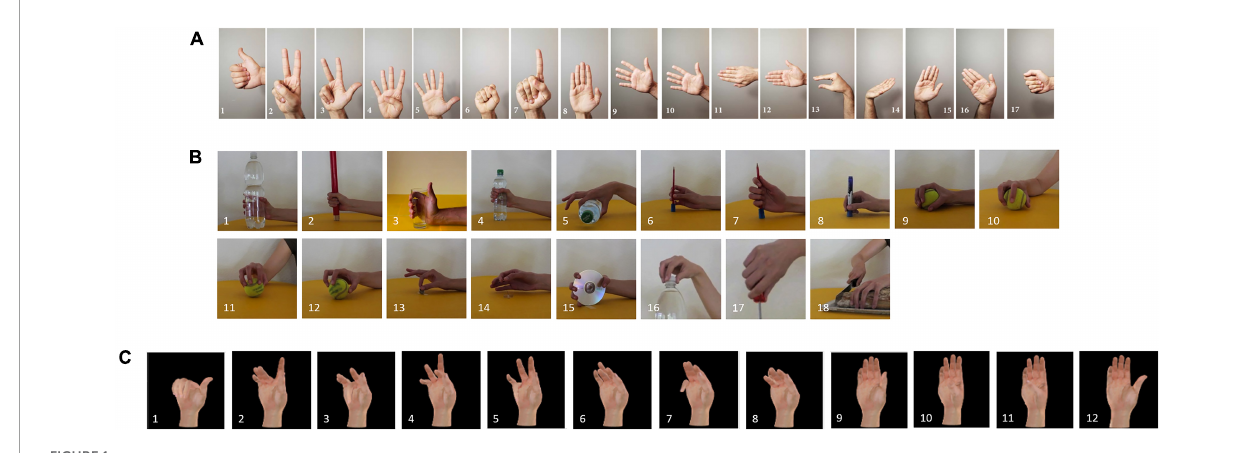
FIGURE1 Types of gestures in the datasets used in this manuscript. (A) Ninapro DB2 exercise B dataset 17 gestures. (B) Ninapro DB5 exercise C dataset 18 gestures. (C) CapgMyo DB-c dataset 12 gestures.